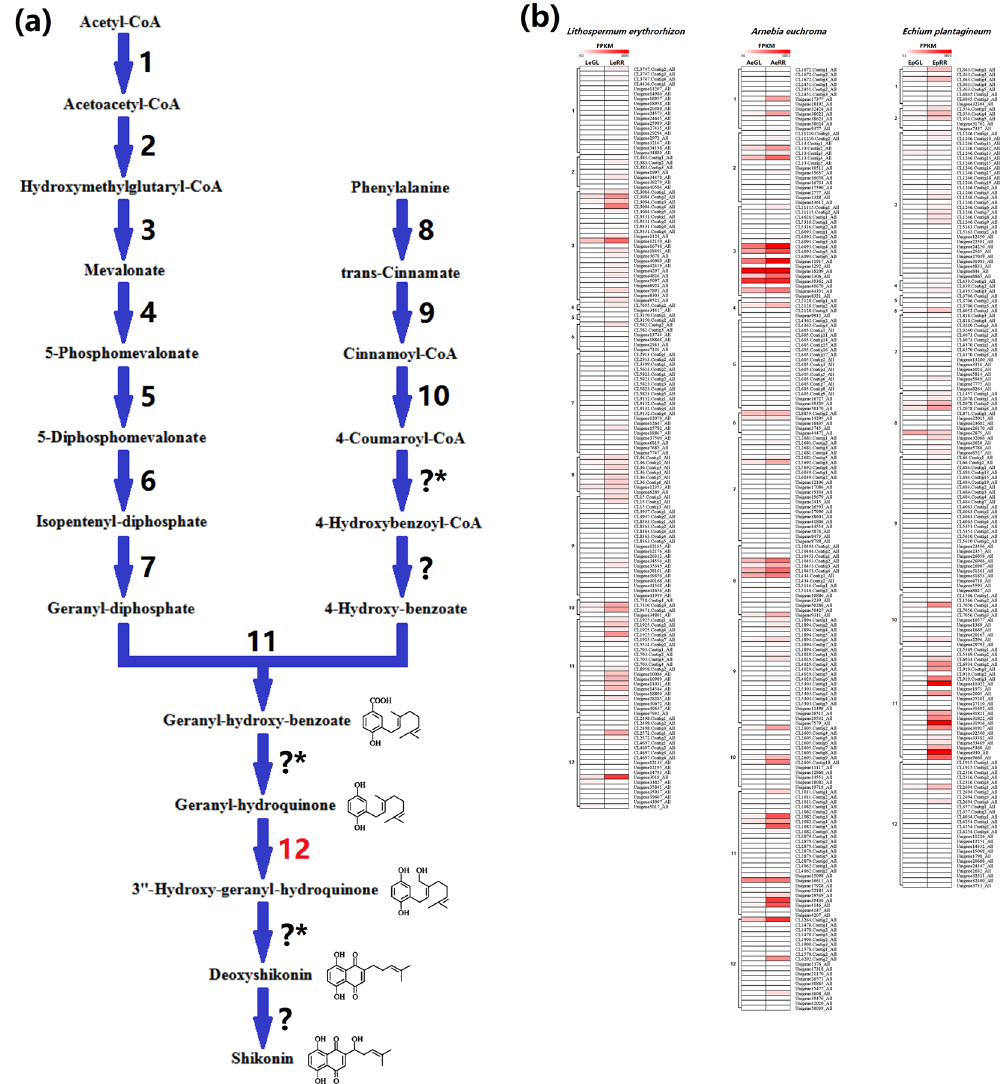
Figure 4. Unigene expression involved in shikonin biosynthesis in Lithospermum erythrorhizon , Arnebia euchroma and Echium plantagineum . ( a ) Shikonin biosynthesis; ( b ) Unigene expressions involved in shikonin biosynthesis? One step unknown? * Several steps unknown; 1. Acetoacetyl-coenzyme A thiolase gene ( AACT ), 2. Hydroxy-methylglutaryl CoA synthase gene ( HMGS ), 3. Hydroxy-methylglutaryl-CoA reductase gene ( HMGR ), 4. Mevalonate kinase gene ( MK ), 5. Phosphomevalonate kinase gene ( PMK ), 6. Mevalonate disphosphate decarboxylase gene ( MVD ), 7. Geranyl diphosphate synthase gene ( GDS ), 8. Phenylalanine ammonia-lyase gene ( PAL ), 9. 4-Coumarate:CoA ligase gene ( 4CL ), 10. Cinnamic acid 4-hydroxylase gene ( C4H ), 11. p-Hydroxybenzoate geranyltransferase gene ( PGT ), 12. Geraniol 10-hydroxylase gene ( G10H ,